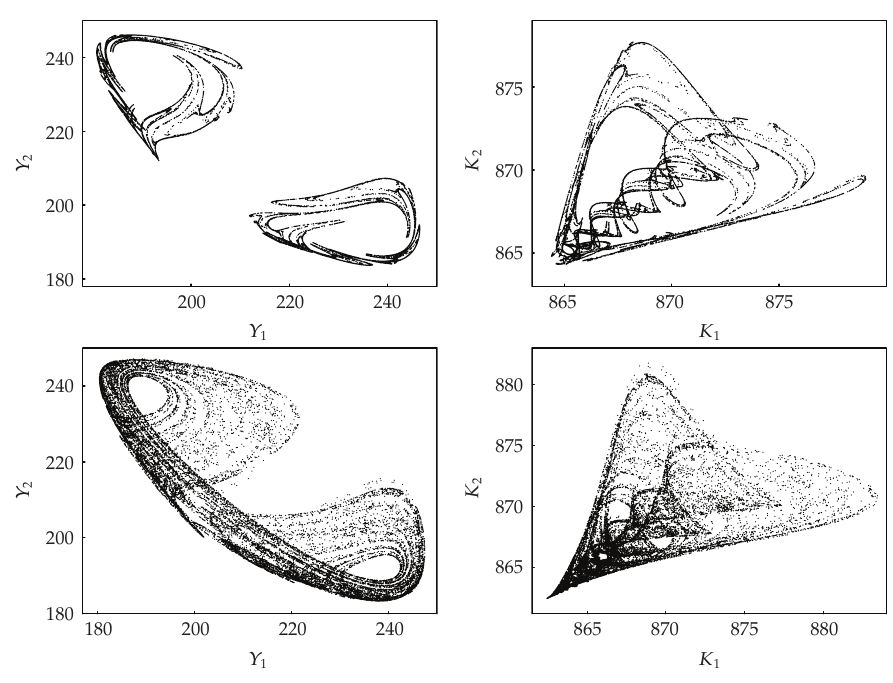
Figure 9: Development of the cycles of Figure 8 into chaotic attractors at: β (cid:9) 9 . 68 (cid:4) top (cid:7) and β (cid:9) 9 . 76 (cid:4) bottom: “mask-like” and “heart-like” attractors (cid:7)